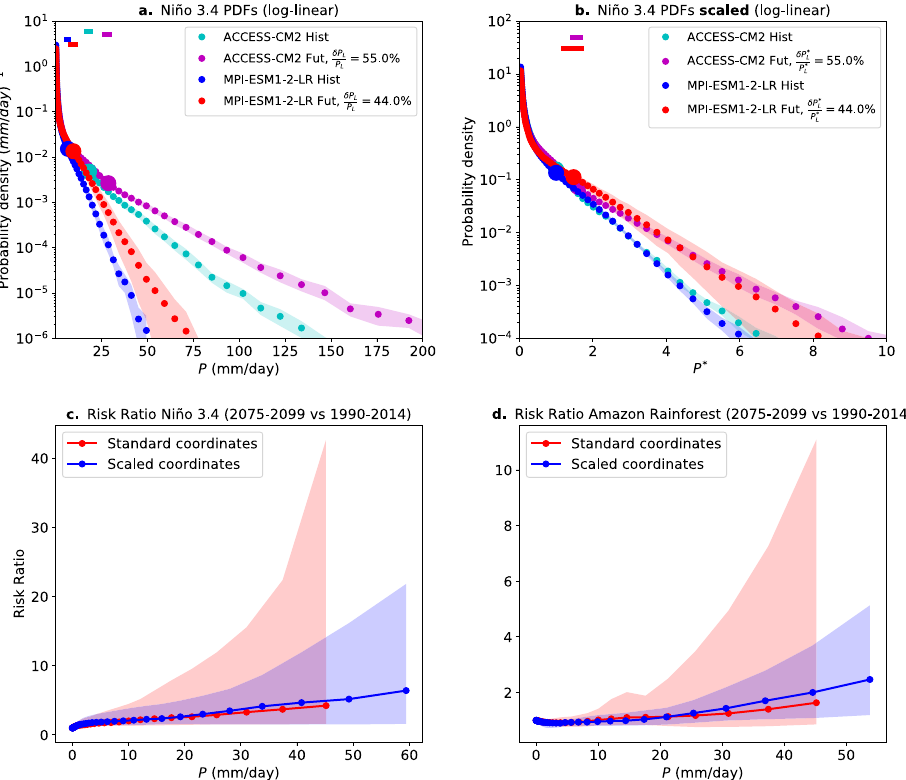
Figure 3. ( a ) To illustrate effects of the rescaling procedure, historical and global warming daily precipitation probability distributions are shown for two models that bracket the range of simulated historical P L in the Niño 3.4 region. Shading denotes the 5–95th percentile range of each model’s PDF from an ensemble of bootstrap realizations (see Methods). The 5th-95th percentile of P L estimations are shown in the top left (corresponding P L values are shown on the respective PDFs as large dots; note these dots are larger than the error bars). ( b ) Same probability distributions as in ( a ) but in scaled coordinates (i.e., P ). This allows an approximate collapse of P his L